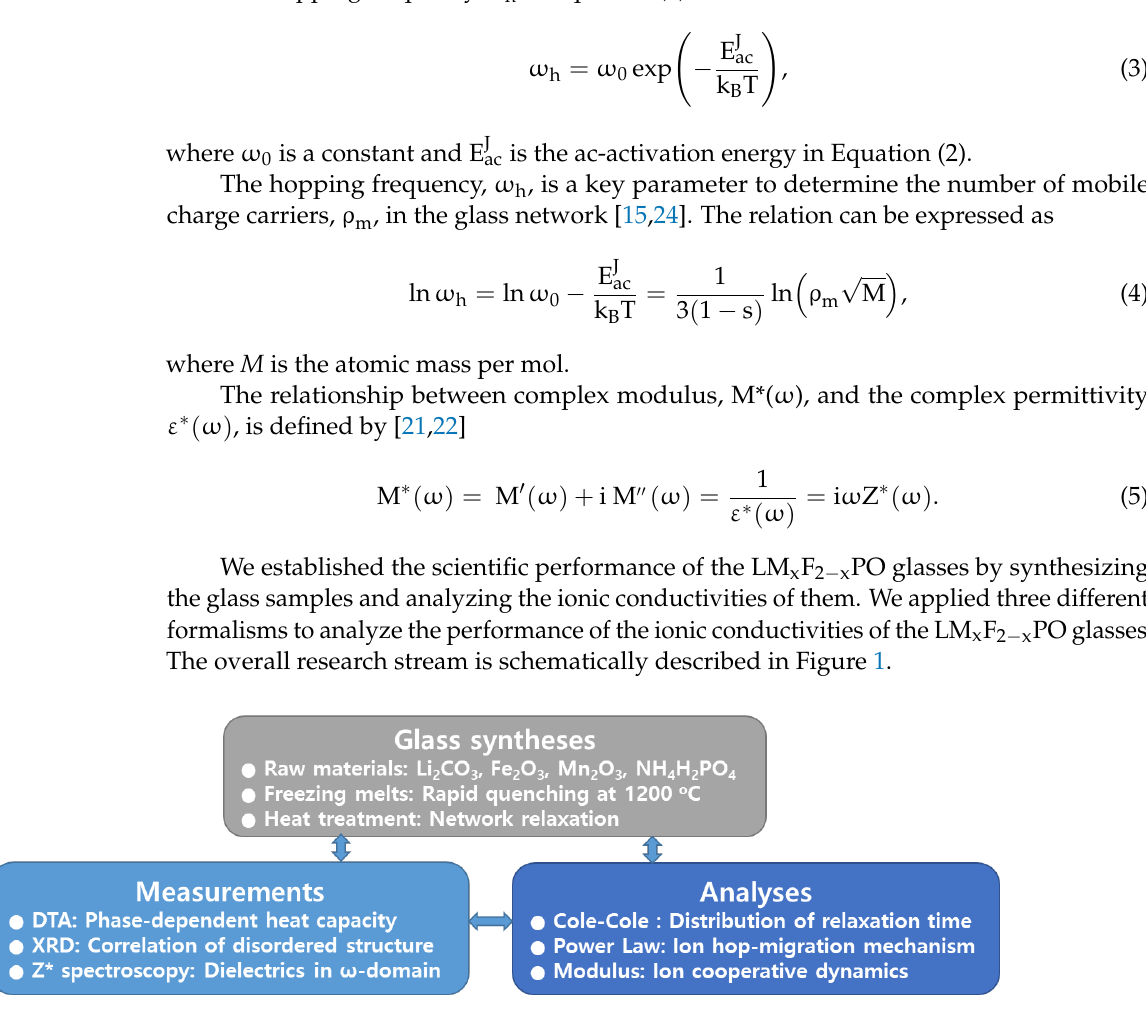
Figure 1. Schematic picture of experimental processes of 3Li 2 O-xMn 2 O 3 -(2-x)Fe 2 O 3 -3P 2 O 5